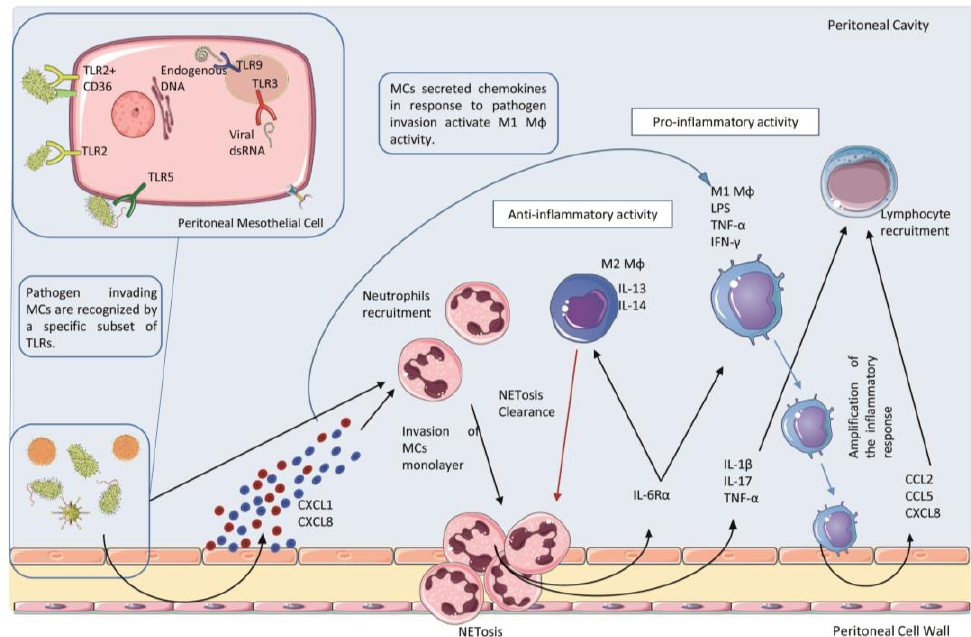
Figure 1. Acute infection and early innate response in the peritoneum. Mesothelial cells (MCs) can sense invading microorganisms through a specific subset of Toll-Like Receptors (TLRs). Pathogen infection stimulates MCs to produce chemokines, such as CXCL1 and CLXL8, which promote the recruitment of a first wave of neutrophils entering the peritoneal cavity and undergo to the process of NETosis. Cytokines and chemokines released both by MCs and Neutrophils during this first wave of the inflammatory process induce the recruitment of mononuclear